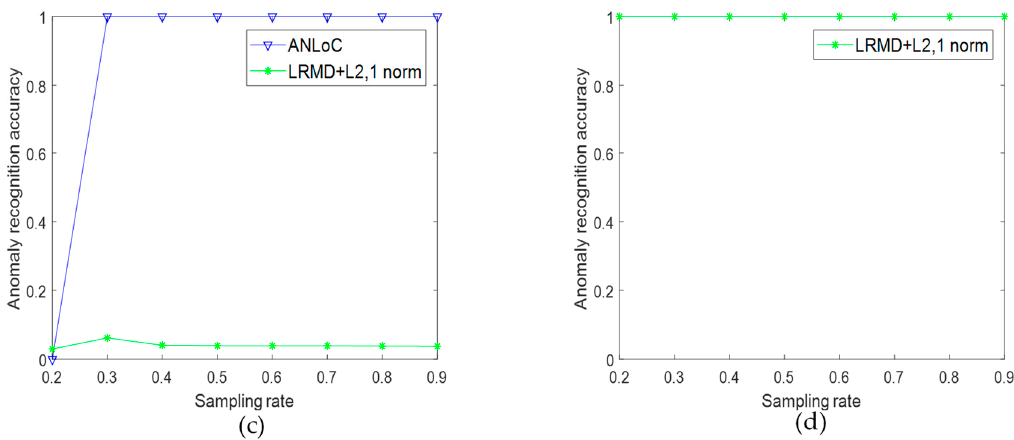
Figure 8. Effects illustration of the proposed strategies. ( a ) EDM recovery error under the scenario 4 with both complex noise and anomaly; ( b ) localization error under the scenario 4 with complex noise and anomaly; ( c ) anomaly recognition accuracy under condition with complex noise and anomaly; and ( d ) anomaly recognition accuracy under the scenario 3 with only anomaly.